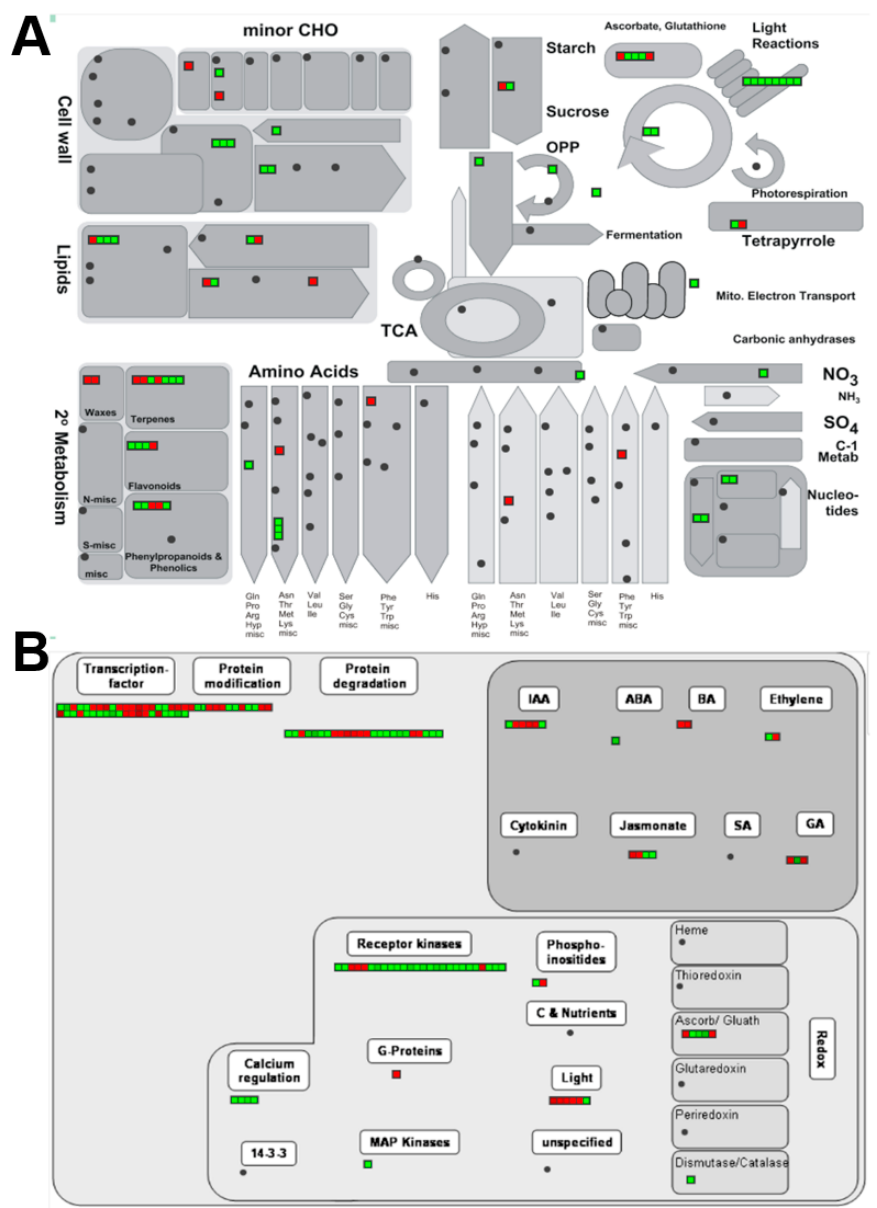
Figure 5. MapMan overview of ( A ) metabolic- and ( B ) regulatory-related DEGs. Each bin represents a single DEG. Red and green indicate up- or down-regulation, respectively.